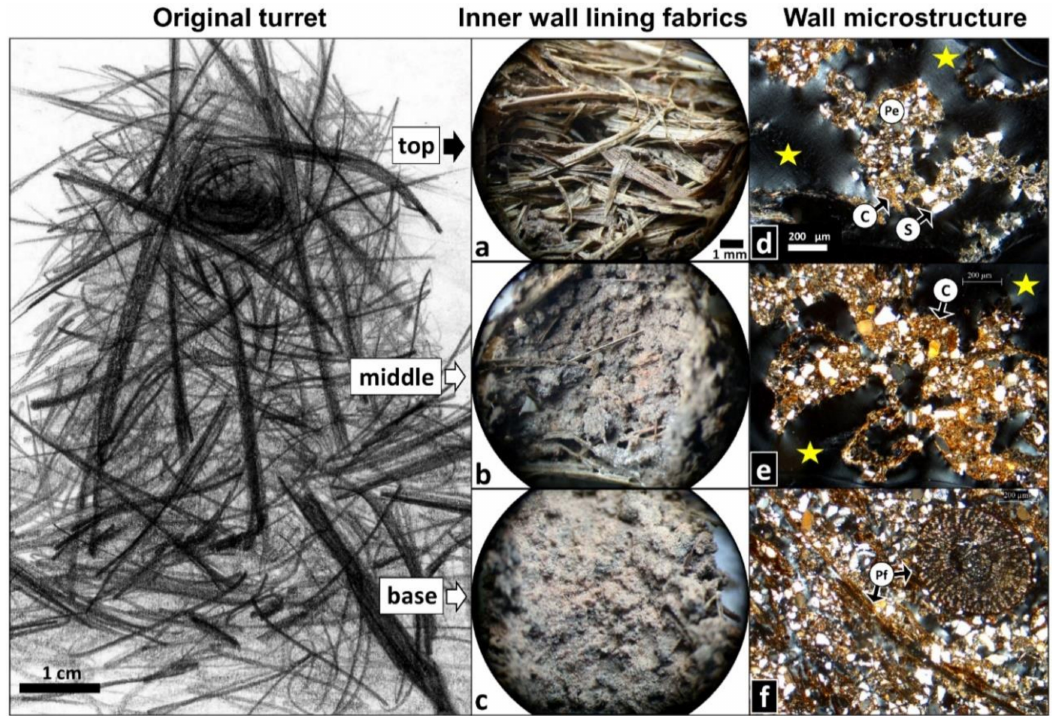
Figure 2. Morphology of original turrets of unknown age collected from field nests (schematic drawing of an entire turret by M. I. Cosarinsky). Shown are the most common lining fabrics found on the inner wall at the turret top, middle, and base, as well as the most common wall microstructures identified on thin sections. Inner wall lining fabrics: ( a ) not lined ( n = 5 / 9, i.e., found in five out of nine turrets). ( b ) Open and intermediate lining fabrics ( n = 7 / 9). ( c ) Close fabric ( n = 7 / 9). Micromorphology of the turret wall: ( d ) pelletal fiber structure ( n = 7 / 10). Highlighted is a pellet (Pe) composed of sand grains (S) of variable size cemented with bright clay (C), i.e., birefringent under polarized light, which may indicate that the clay aggregate contained no or only very few organic materials. Voids are indicated with yellow stars. ( e ) Cemented fiber structure ( n = 8 / 10). The highlighted, darker clay is likely mixed with organic material. ( f ) Spongy structure ( n = 6 / 10). Highlighted are plant fragments (Pf) embedded in the structure, one of them transversally sectioned. For detailed descriptions of linings and microstructures see text. Scale bar in ( a ) is also valid for ( b ) and ( c ); scale bar in ( d ) is also valid for ( e ) and ( f ). Photo credits: M. I.